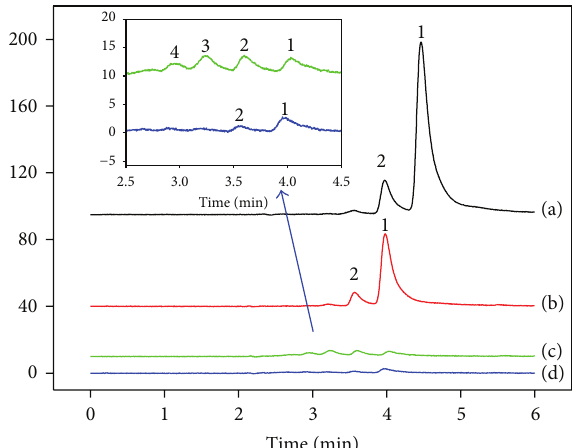
Figure 7: HPLC analyses of MB. (a) Initial MB solution at 15 ppm, (b) equilibrium MB solution after 30 min absorption in the dark, (c) after UV irradiation for 5min, and (d) after irradiation for 20